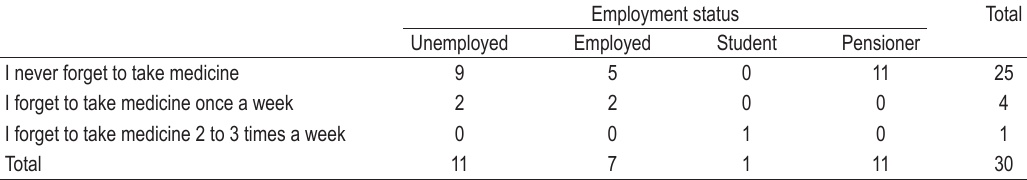
Table 3. Frequency of forgetting to take medicine